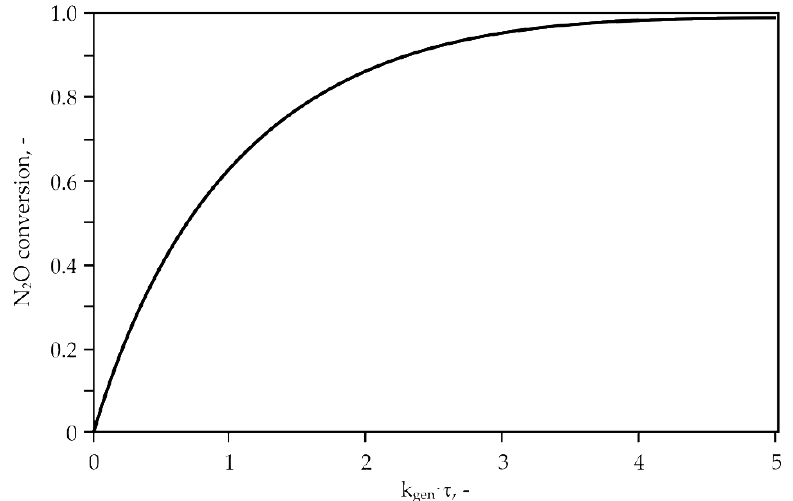
Figure 6. The dependence of N 2 O conversion on the product of a reaction rate constant and residence time according to first-order rate law (Equation (3)).